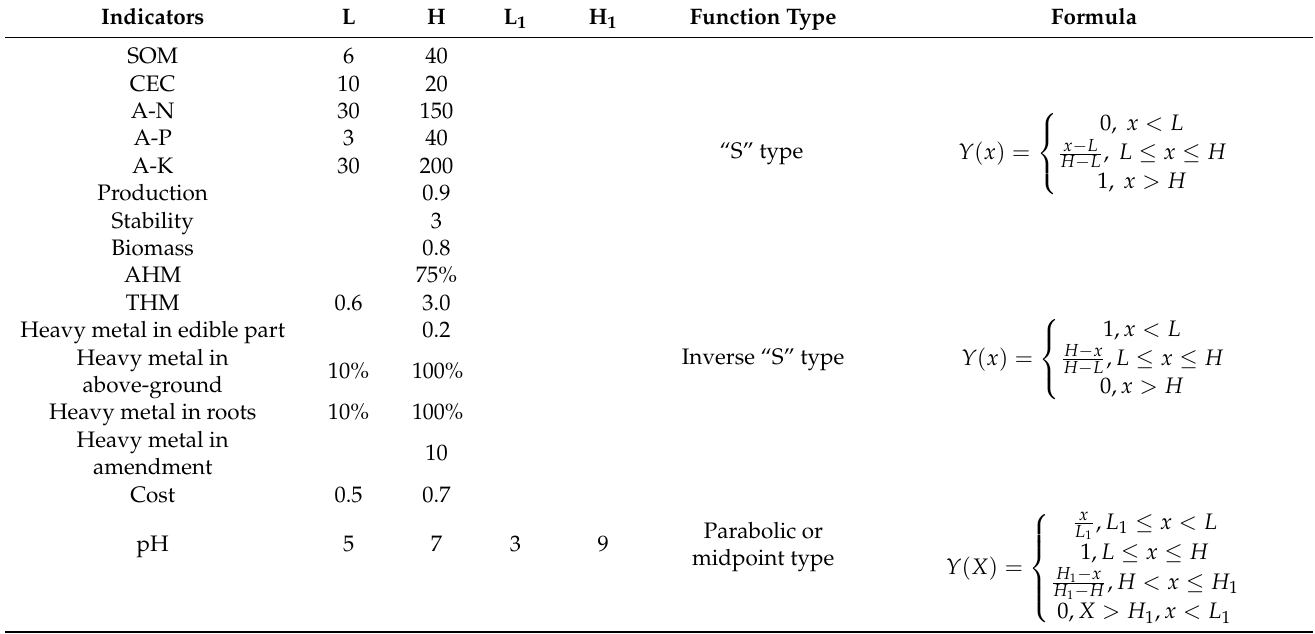
Table 6. Different evaluation indicators and applicable response curve models.